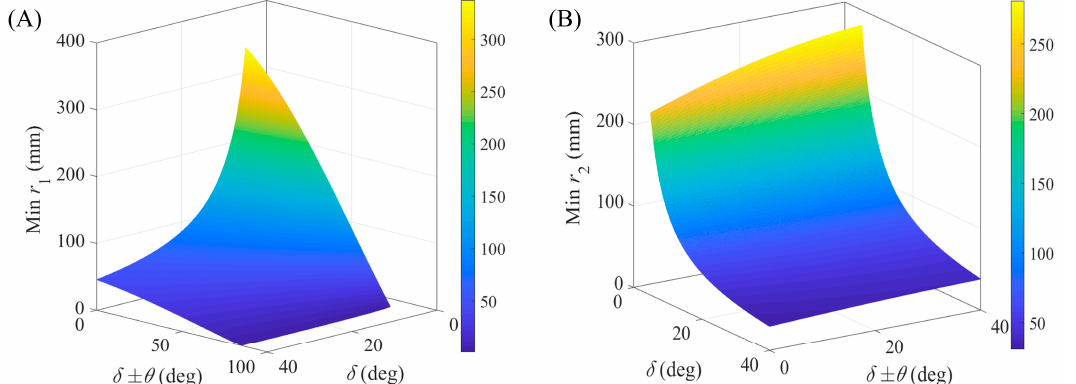
Figure 6. The relationship between the distance from the robot to the arc surface (hi), the feasible arc radius (ri) and support position ( δ ), and the leg support posture ( θ ) ( δ ± θ means the angle between the support leg and the vertical line, and the positive and negative signs can be judged in Figure 5). ( A ) The minimum outer radius arc during crawling, when the friction support angle φ m is 40 ° , and the range of leg support angle is ( − 40 ° to 50 ° ); ( B ) the minimum distance from the bottom of the robot to the outer arc, when the friction support angle φ m is 40 ° , and the range of leg support angle is ( − 40 ° to 50 ° ).